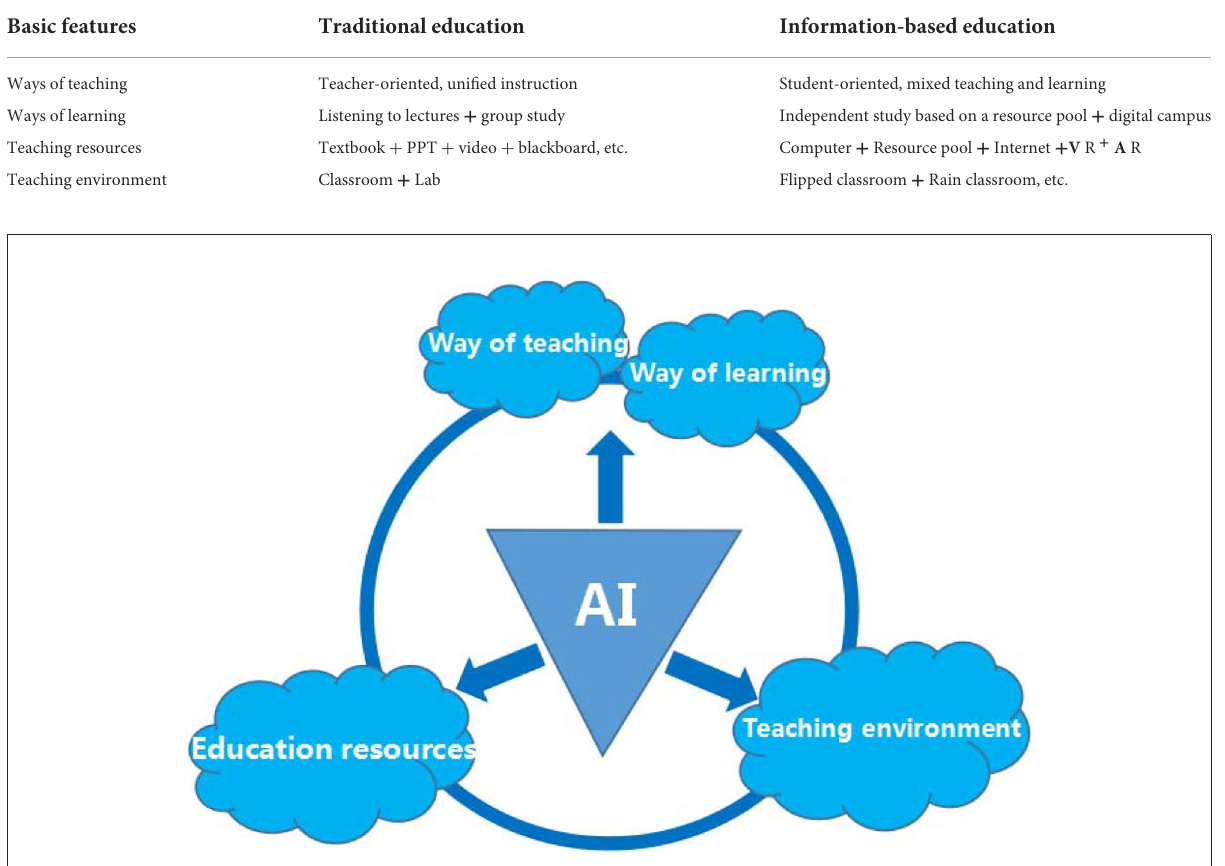
TABLE 4 Analysis of the basic characteristics of traditional education and information-based education.